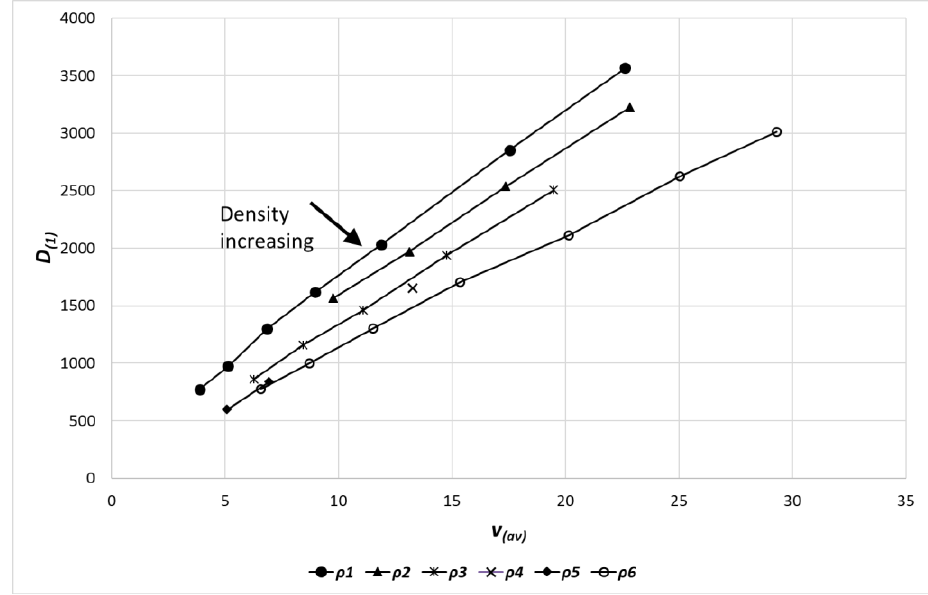
Figure 7. The dependence of the first vorticity derivative in the axis on the average velocity for different densities.